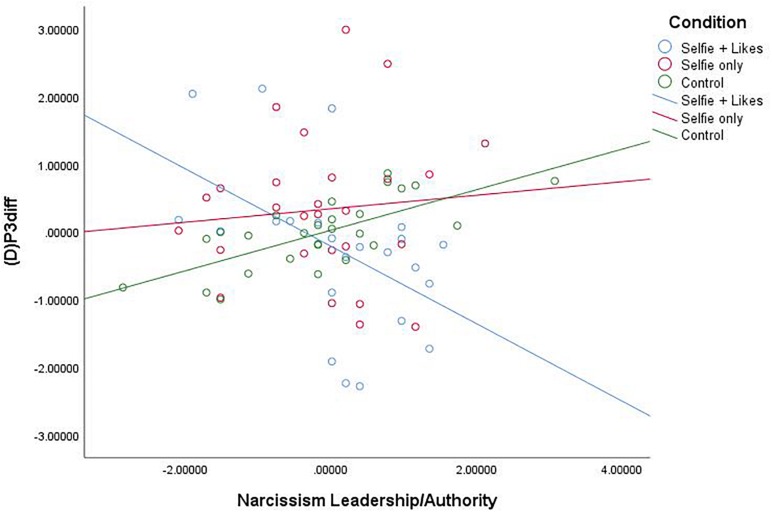
Scatterplot for the interaction between condition and Narcissism—Leadership/Authority (Z score) on white noise P3diff mean amplitude change scores (Z score).